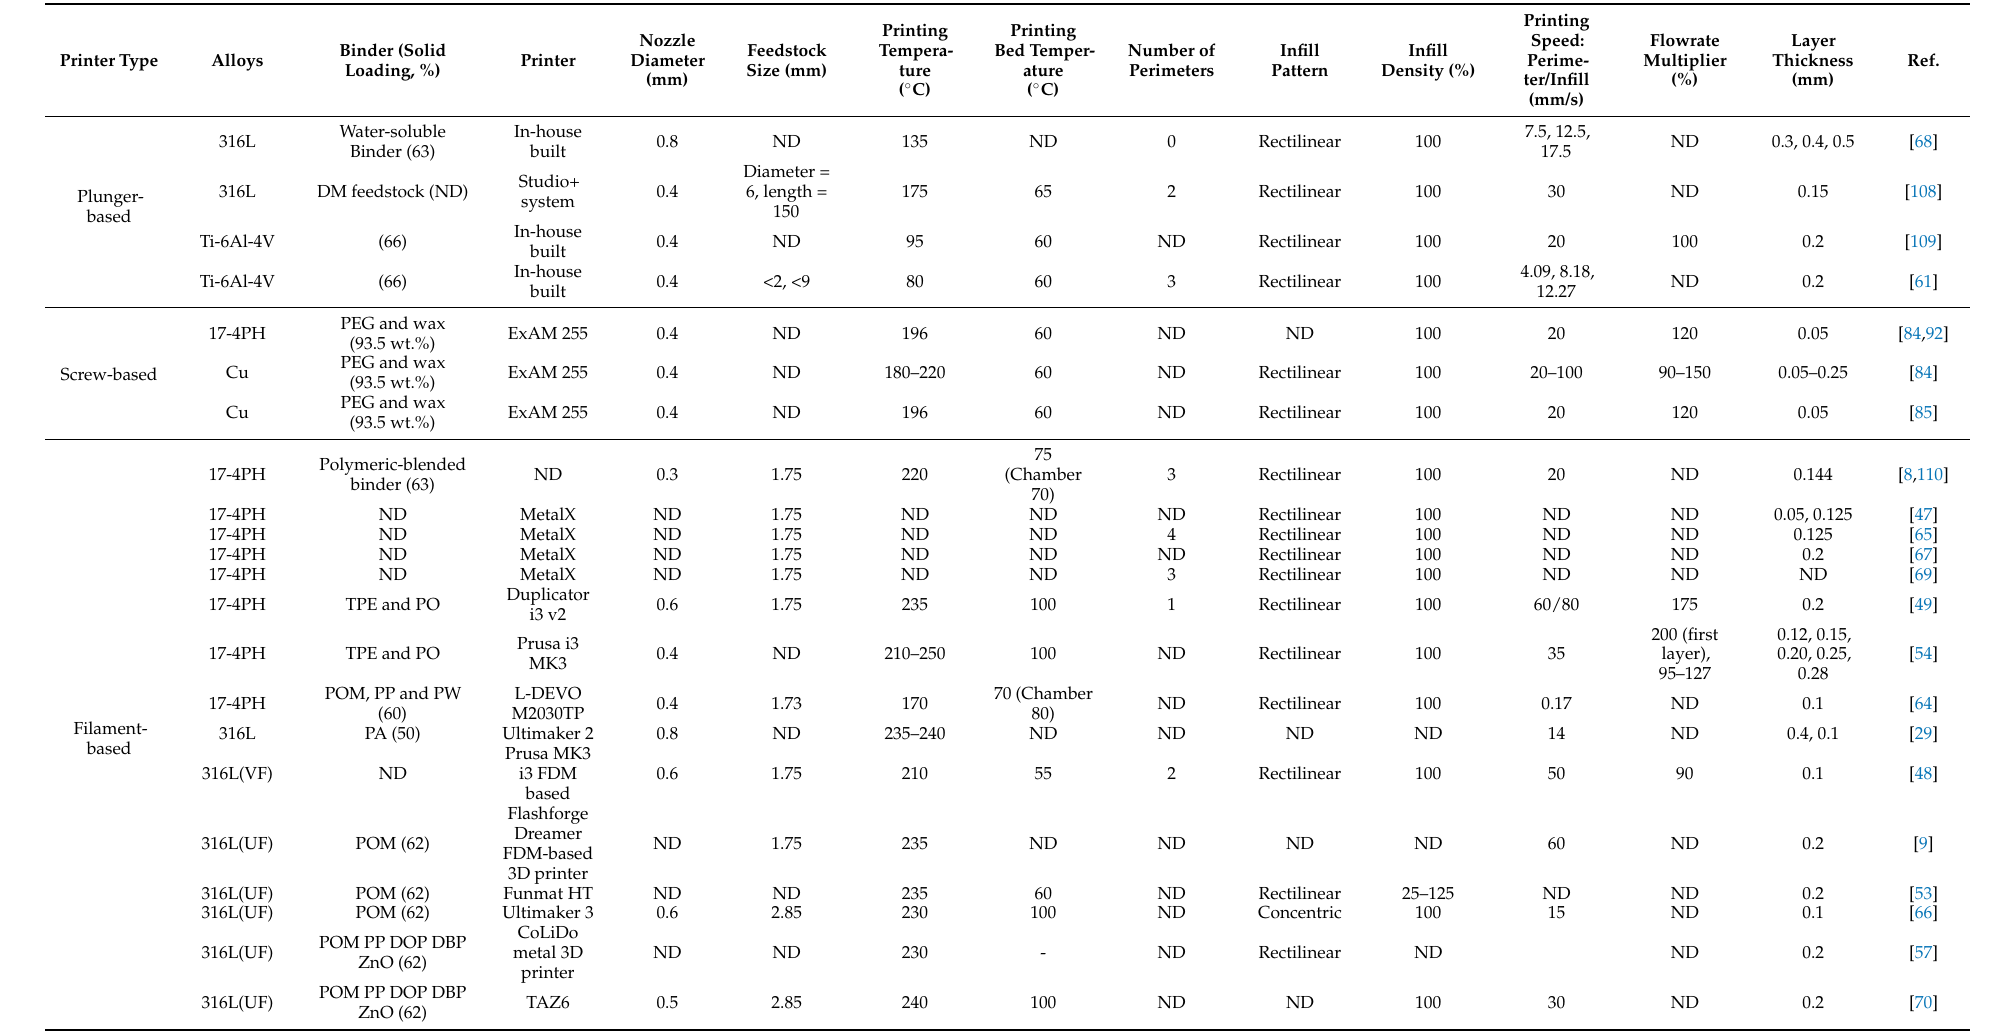
Table 4. Printing parameters reported in the literature classified by feeding system corresponding to Table 3 (ND is no detail; VF is Virtual Foundry filament; UF is Ultrafuse filament).